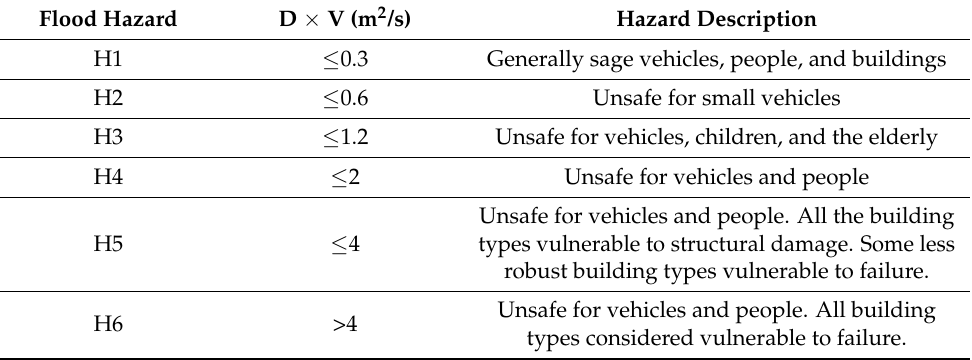
Table 4. Flood hazard classification based on the flood depth and flood velocity according to the AIDR